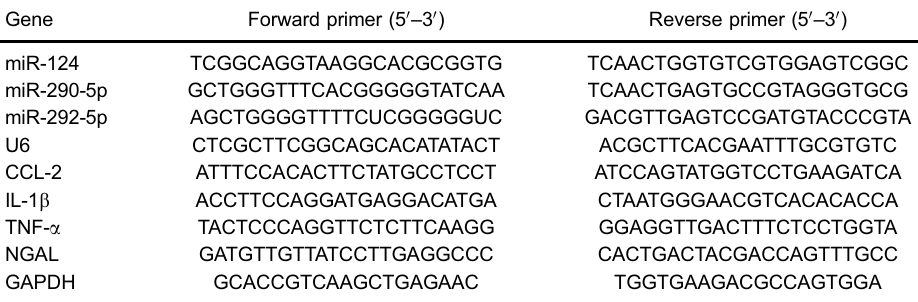
Table 1. Primers for